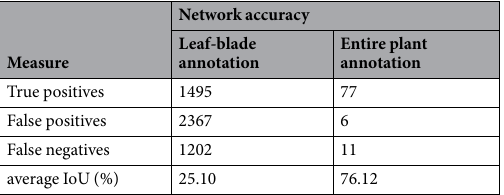
Table 1. Training accuracy for network assessment of two convolutional neural networks trained to detect goosegrass developed in Balm, FL, USA in 2018 a . a Threshold for detection was 0.25 or 25% intersection of union between the predicted and ground truth bounding